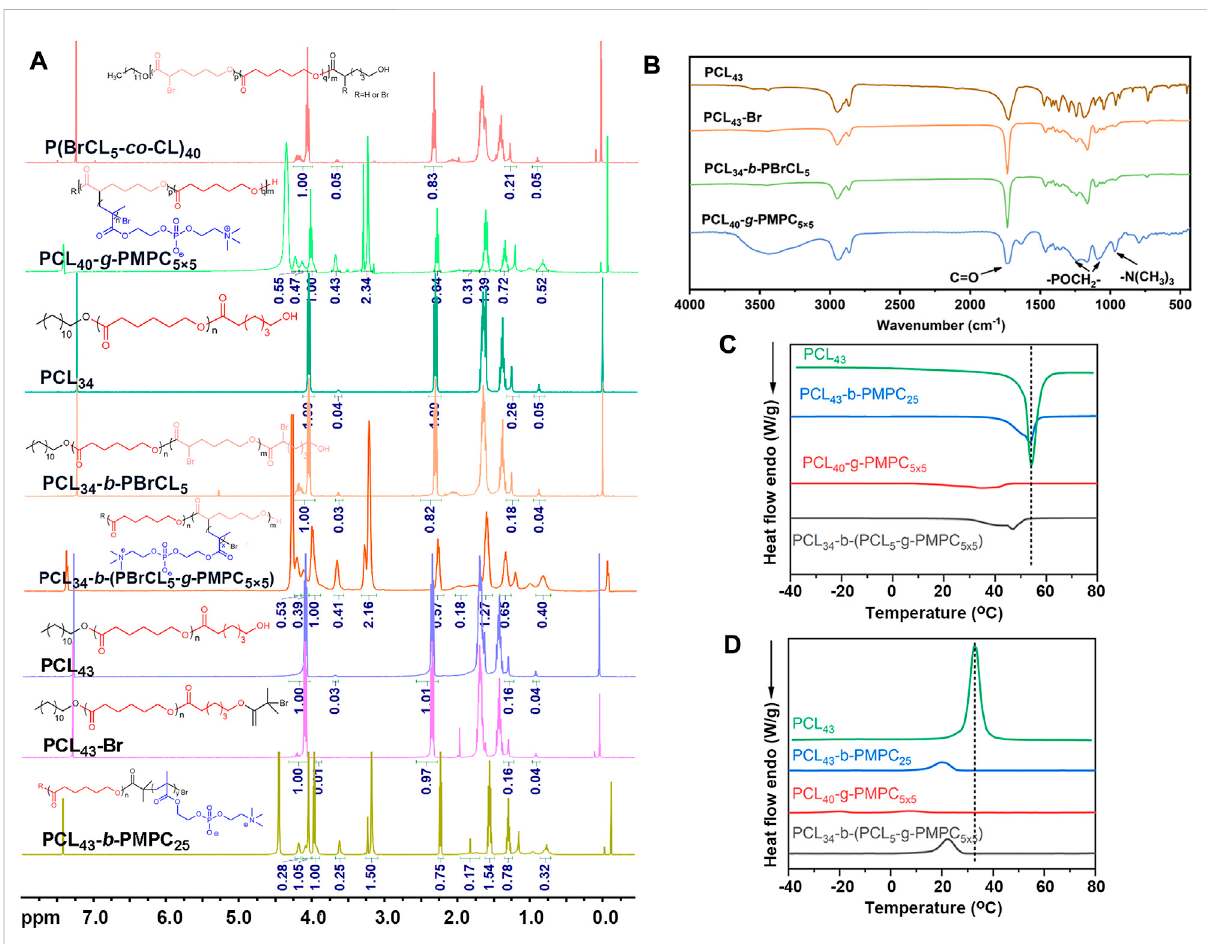
FIGURE 1 (A) 400 M 1 HNMRspectraofdifferentcopolymersinCDCl 3 . (B) FTIRspectraofdifferentcopolymers. (C) DSCcurveofdifferentcopolymersfor heating. (D) DSC curve of different copolymers for